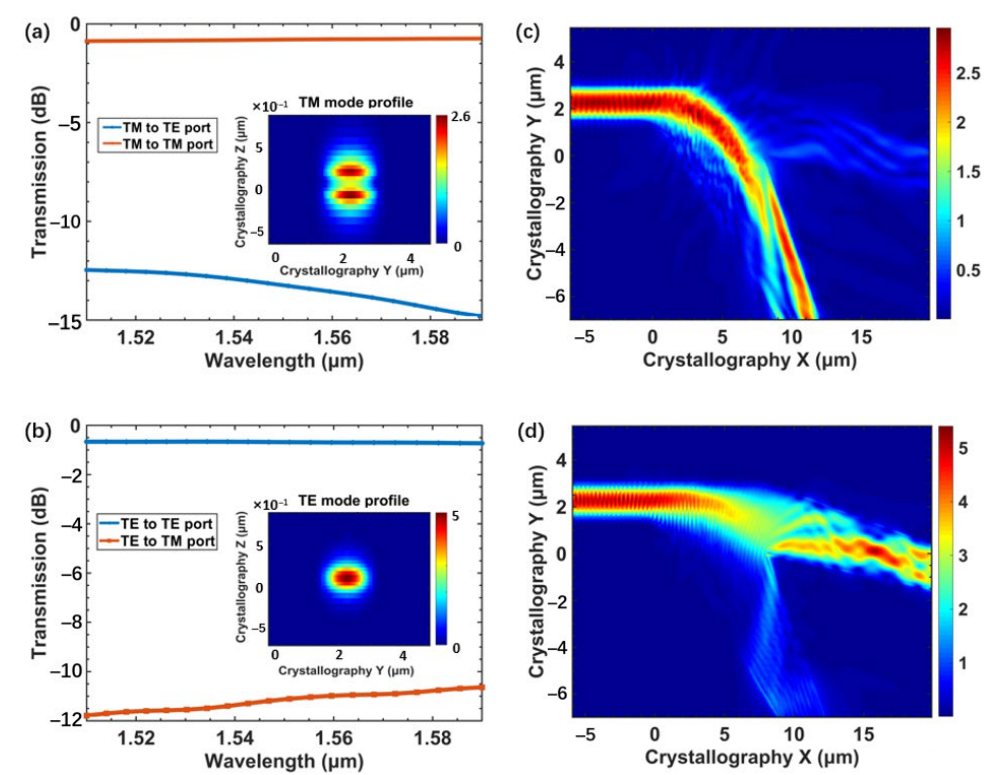
Figure 4. The simulated normalized transmission spectra with detected mode profiles for ( a ) TM mode and ( b ) TE mode. E-field profiles of the propagation along the device for ( c ) TM mode and ( d ) TE mode.